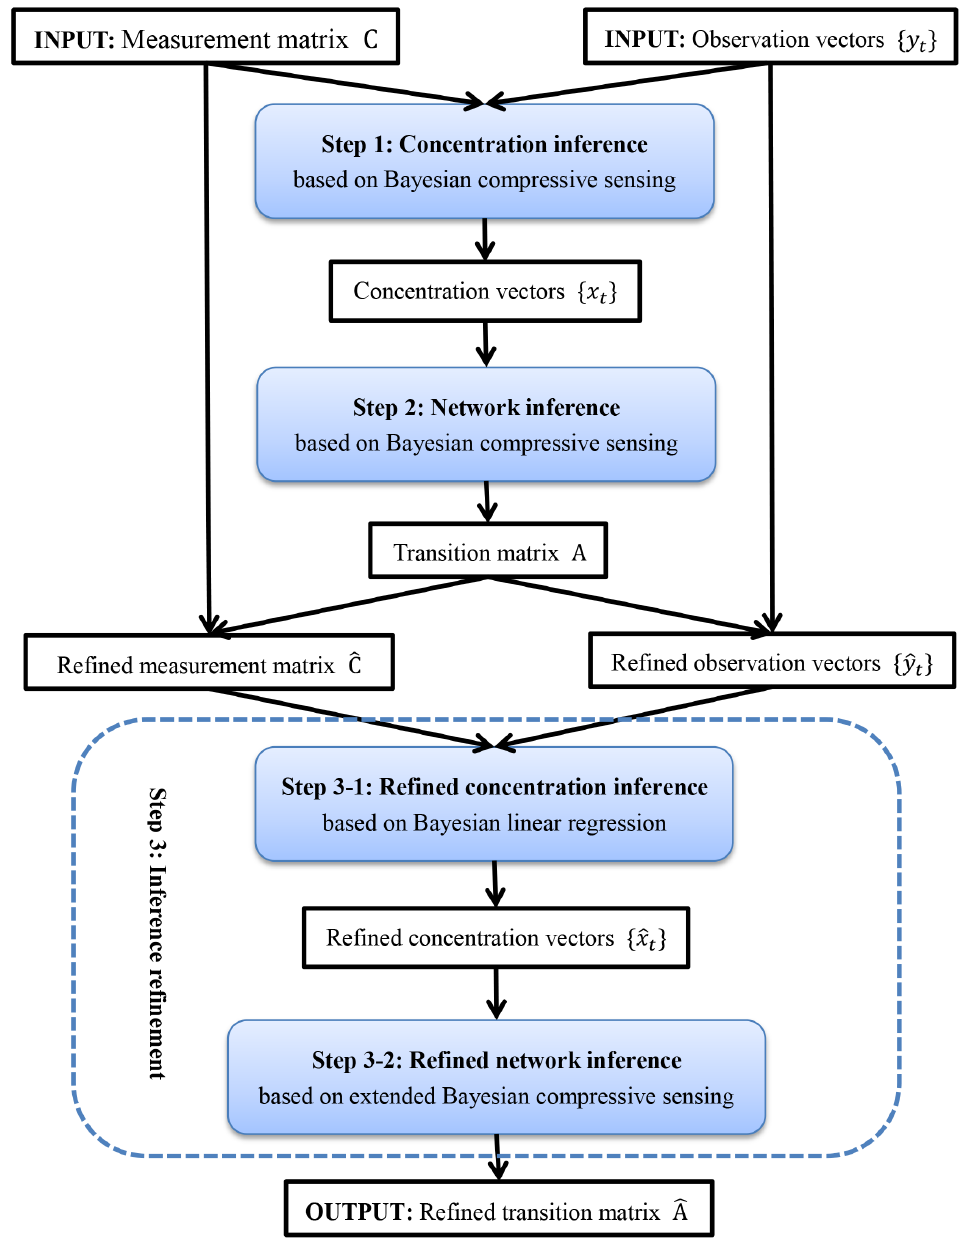
Figure 1. The workflow of CCELL. The CCELL method consists of 3 steps: concentration inference, network inference and inference refinement (including refined concentration inference and refined network inference). The core algorithm of the first two steps is Bayesian compressive sensing. The two substeps in Step 3 are based on Bayesian linear regression and extended Bayesian compressive sensing respectively. The input of CCELL is a measurement matrix C and its corresponding observation vectors y t that are time-series generated by immunoprecipitation assays. The output of CCELL is a refined transition matrix ^ AA representing the cell-scale signalling network.